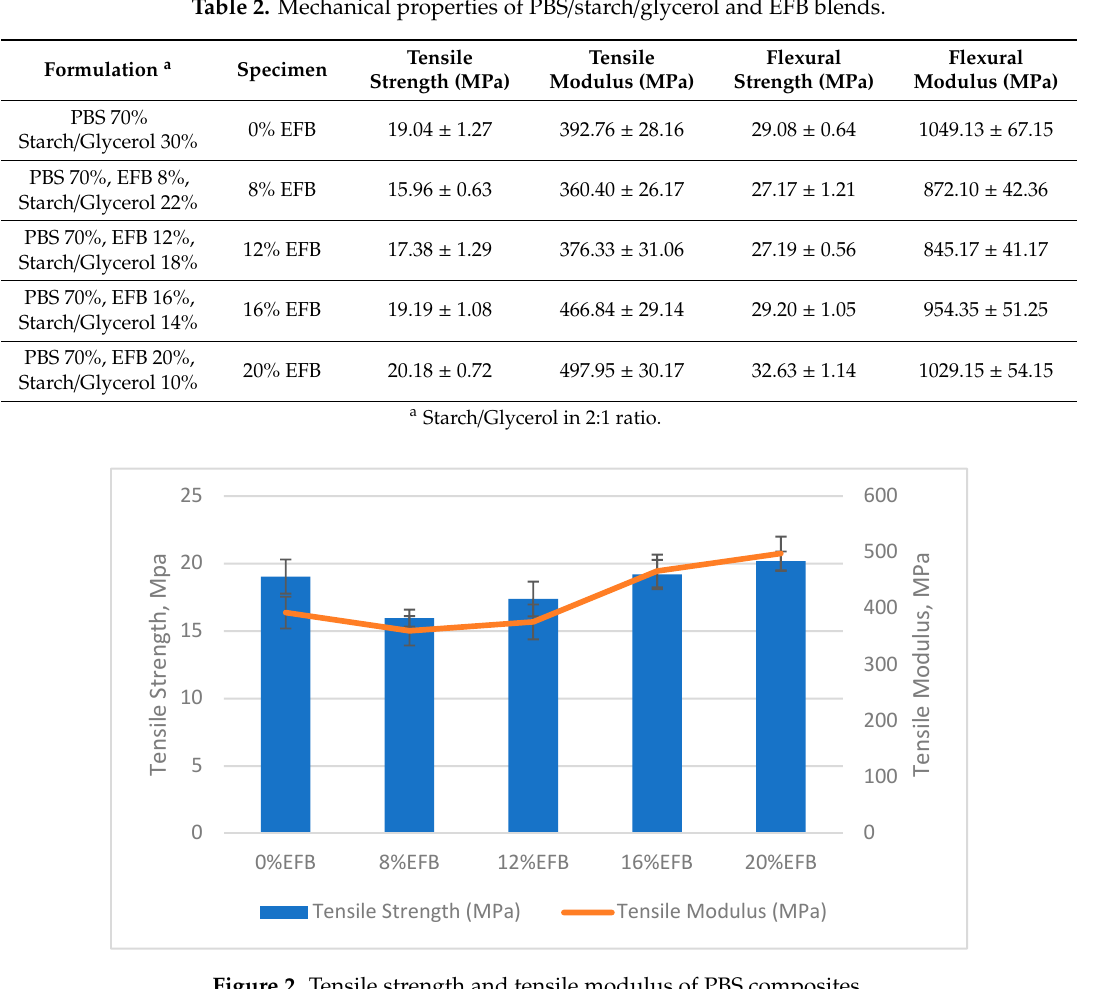
Figure 2. Tensile strength and tensile modulus of PBS composites.